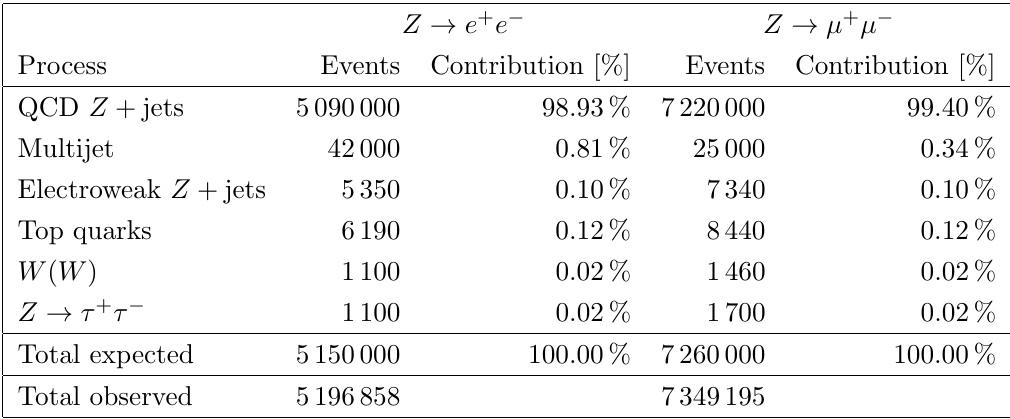
Table 1. Observed and expected numbers of events in the electron and the muon channels. The signal as well as the electroweak Z + jets, WW , W + jets, t (cid:22) t and single-top background rates are estimated using dedicated Monte Carlo samples. The multijet background is estimated using a data-driven